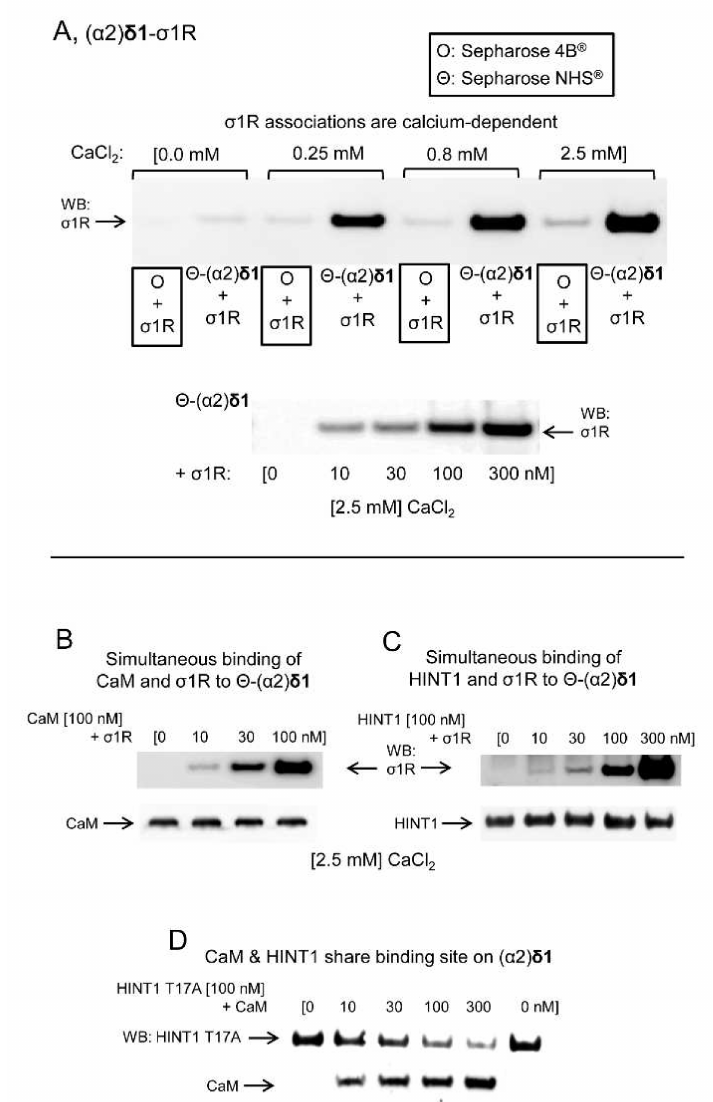
Figure 7. Physical interactions of the ( α 2) δ 1 peptide with σ 1Rs, HINT1 proteins, and CaM. ( A ) Calcium-dependent binding of σ 1Rs to ( α 2) δ 1 peptides. Recombinant ( α 2) δ 1 peptides covalently attached to NHS-activated Sepharose ® were incubated with σ 1Rs (100 nM) in the presence of in- creasing amounts of CaCl 2 . The pellets obtained were washed, solubilized in 2 × Laemmli buffer containing β -mercaptoethanol, and resolved by SDS-PAGE. The presence of σ 1R was analyzed in Western blots (WBs). The prey protein did not bind to NHS-Sepharose (O + σ 1R, negative control). In another set of assays, ( α 2) δ 1 peptides were incubated with increasing concentrations of σ 1Rs in the presence of CaCl 2 (2.5 mM). ( B – D ) Competition assays between σ 1R, HINT1, and CaM for their binding to ( α 2) δ 1 peptides. CaM (100 nM) was incubated with agarose-( α 2) δ 1 for 30 min at RT in 300 µ L of 50 mM Tris-HCl, [pH 7.5], 0.2% CHAPS, CaCl 2 (2.5 mM). After removal of the unbound CaM, increasing concentrations of σ 1Rs were added. The ( α 2) δ 1-bound proteins were detached, resolved by SDS-PAGE chromatography, and analyzed in Western blots (see Section 2). The assays were repeated at least twice, producing comparable results. This protocol was also used to assess competition between HINT1/ σ 1R and CaM/HINT1 in their binding to ( α 2) δ 1 peptides. O and Θ represents plain agarose and NHS-Sepharose ® ,